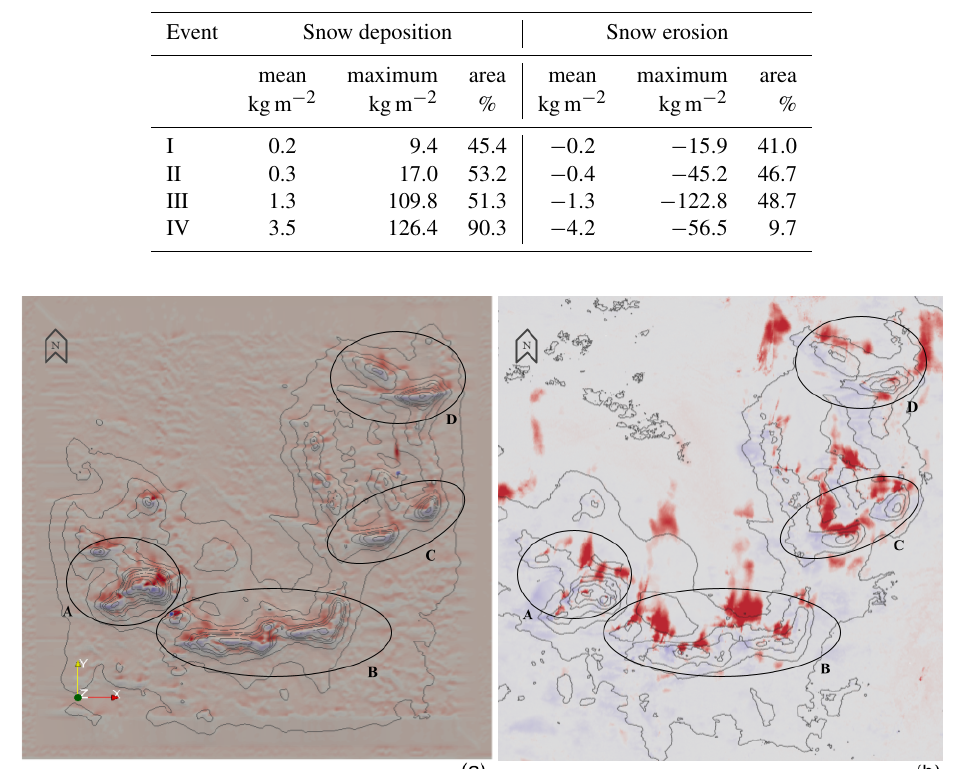
Table 3. Numerical quantitative results for the OpenFOAM sea ice simulations per identified event (I–IV) between 6 and 13 November 2019. Average values, maxima, and relative areal proportion for snow deposition and erosion are presented.